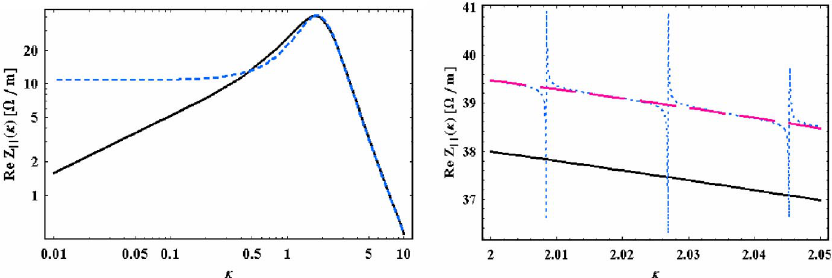
FIG. 3. (Color) Real part of the longitudinal impedance for the lossless ceramic pipe with copper cover. Left: the smooth part of the impedance (dotted curve); the vertical axis has logarithmical scale. Right: the fine structure of impedance (dotted line) and its smooth part (dashed line). The solid curve is the impedance of homogeneous tube with infinite copper